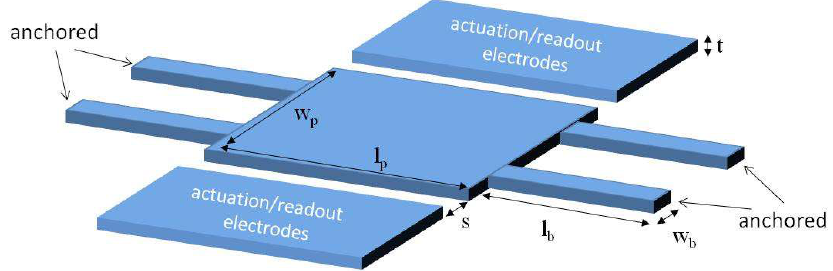
Figure 1. Schematic showing resonator dimension parameters.